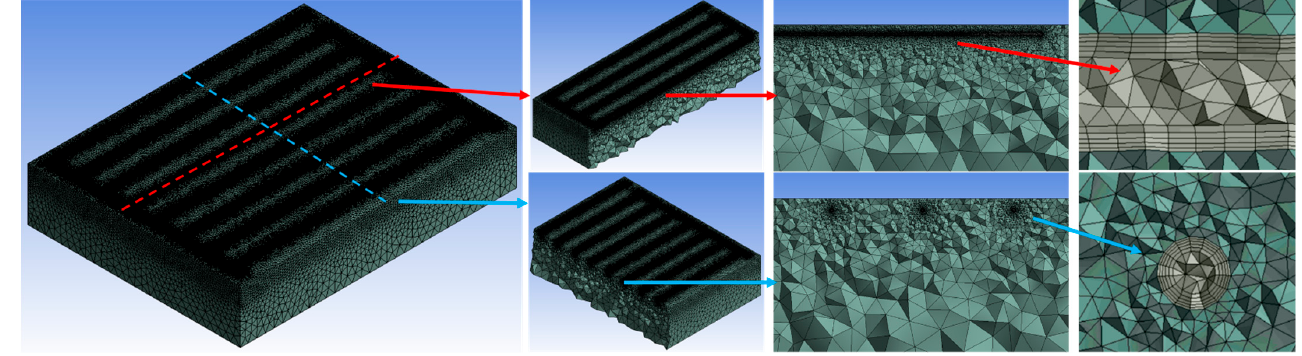
Figure 6. Numerical model calculation grid.